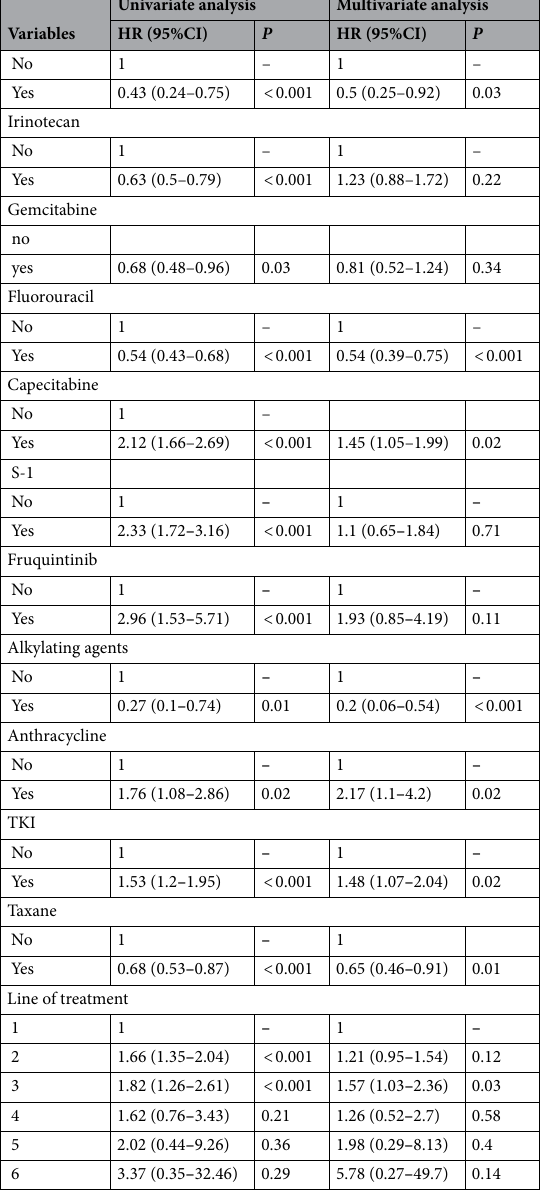
Table 4. Univariate analysis, multivariate analysis, and factors for building the prediction model based on chemotherapy